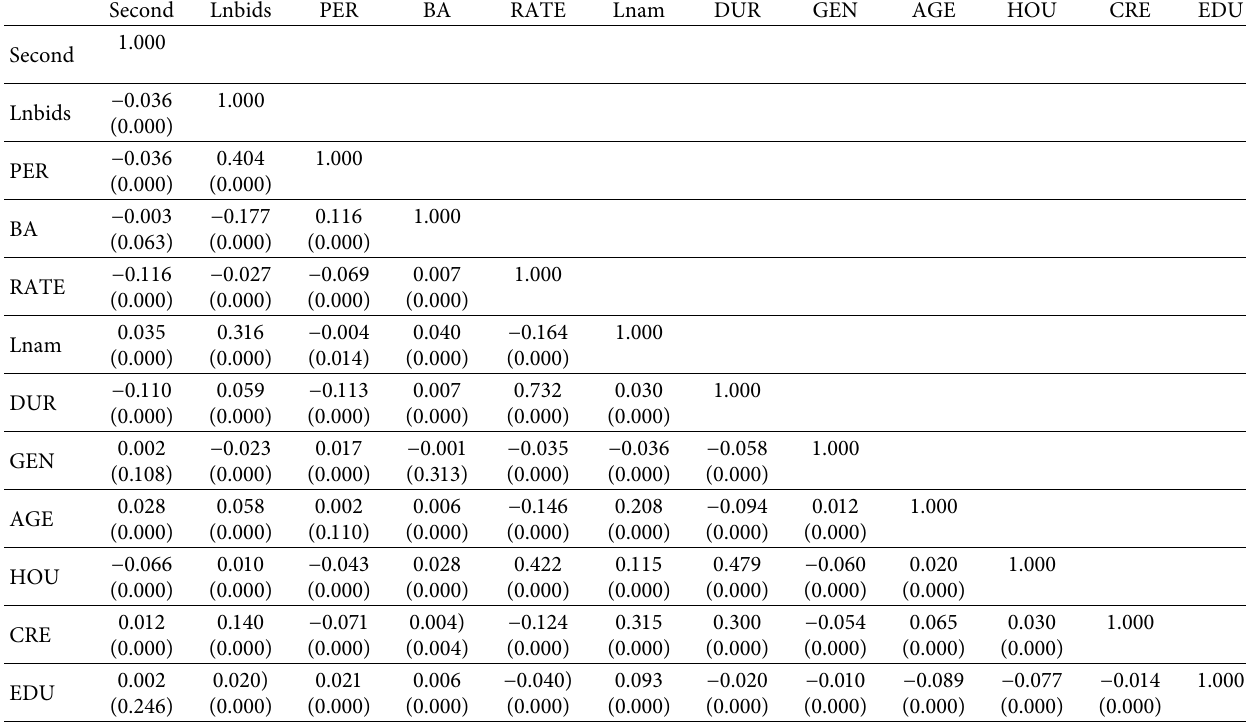
Table 4: Correlation between the control variables and the main independent variables.